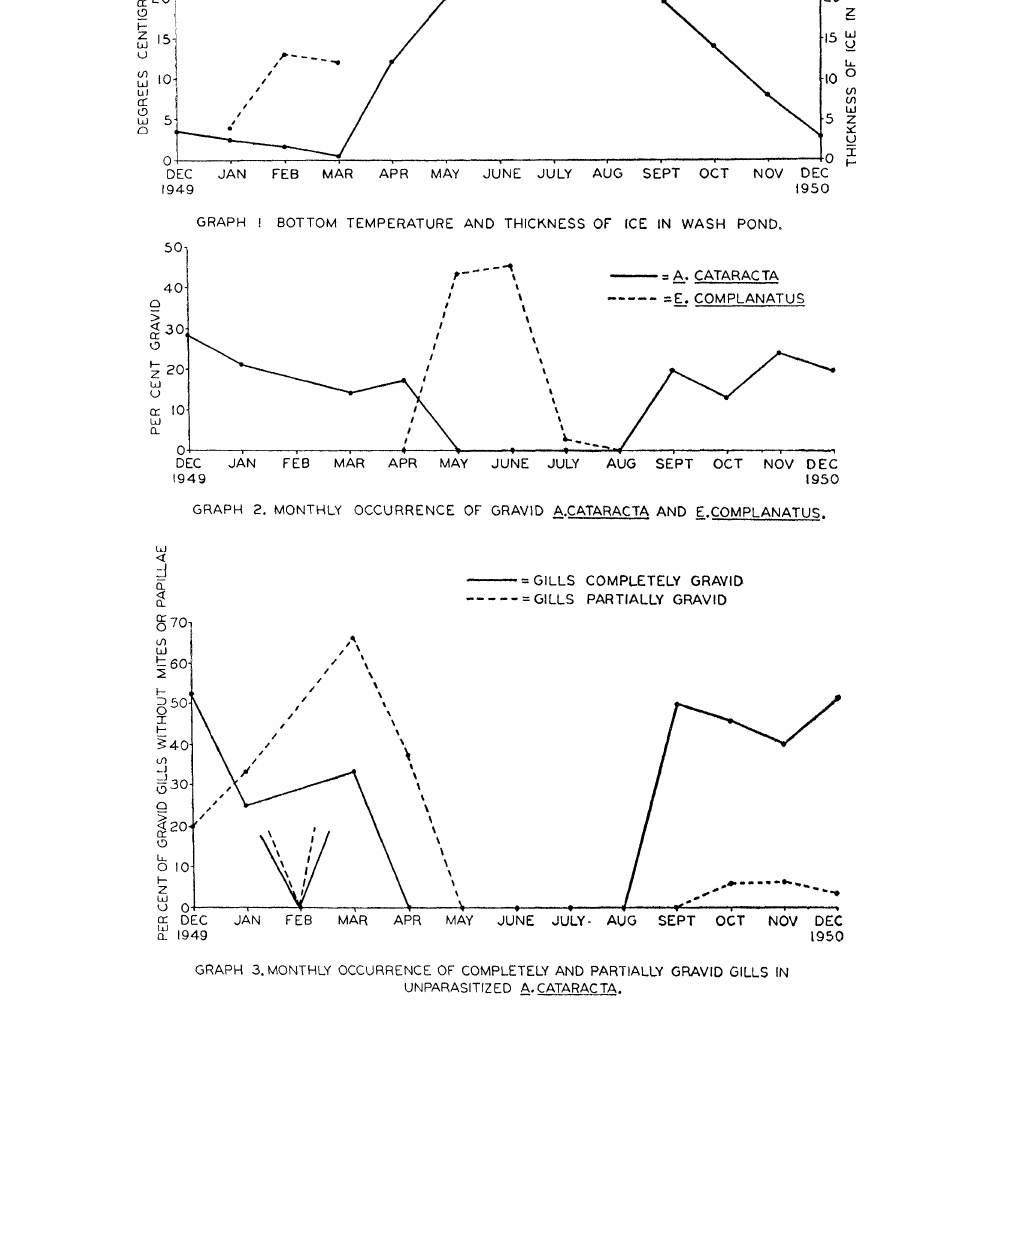
BOTTOM TEMPERATURE AND THICKNESS OF ICE IN WASH POND.